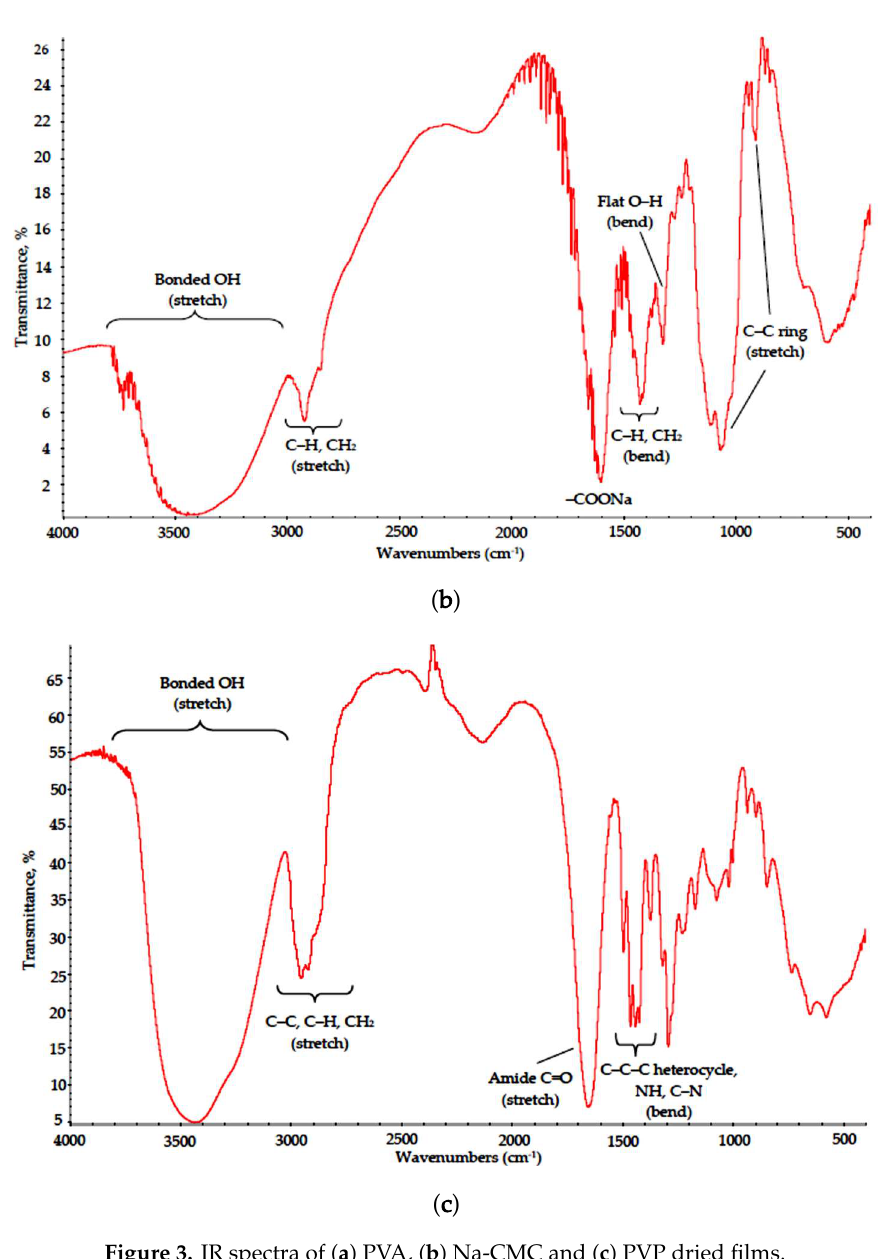
Figure 3. IR spectra of ( a ) PVA, ( b ) Na-CMC and ( c ) PVP dried films.